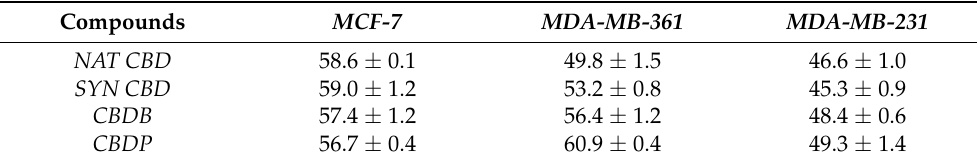
Table 1. IC 50 values ( µ M) are reported as mean ± S.D. of three independent experiments ( n = 3). MCF-7, MDA-MB-361 and MDA-MB-231 cells were treated with nat CBD, syn CBD, CBDB and CBDP (from 0 to 100 µ M) for 24